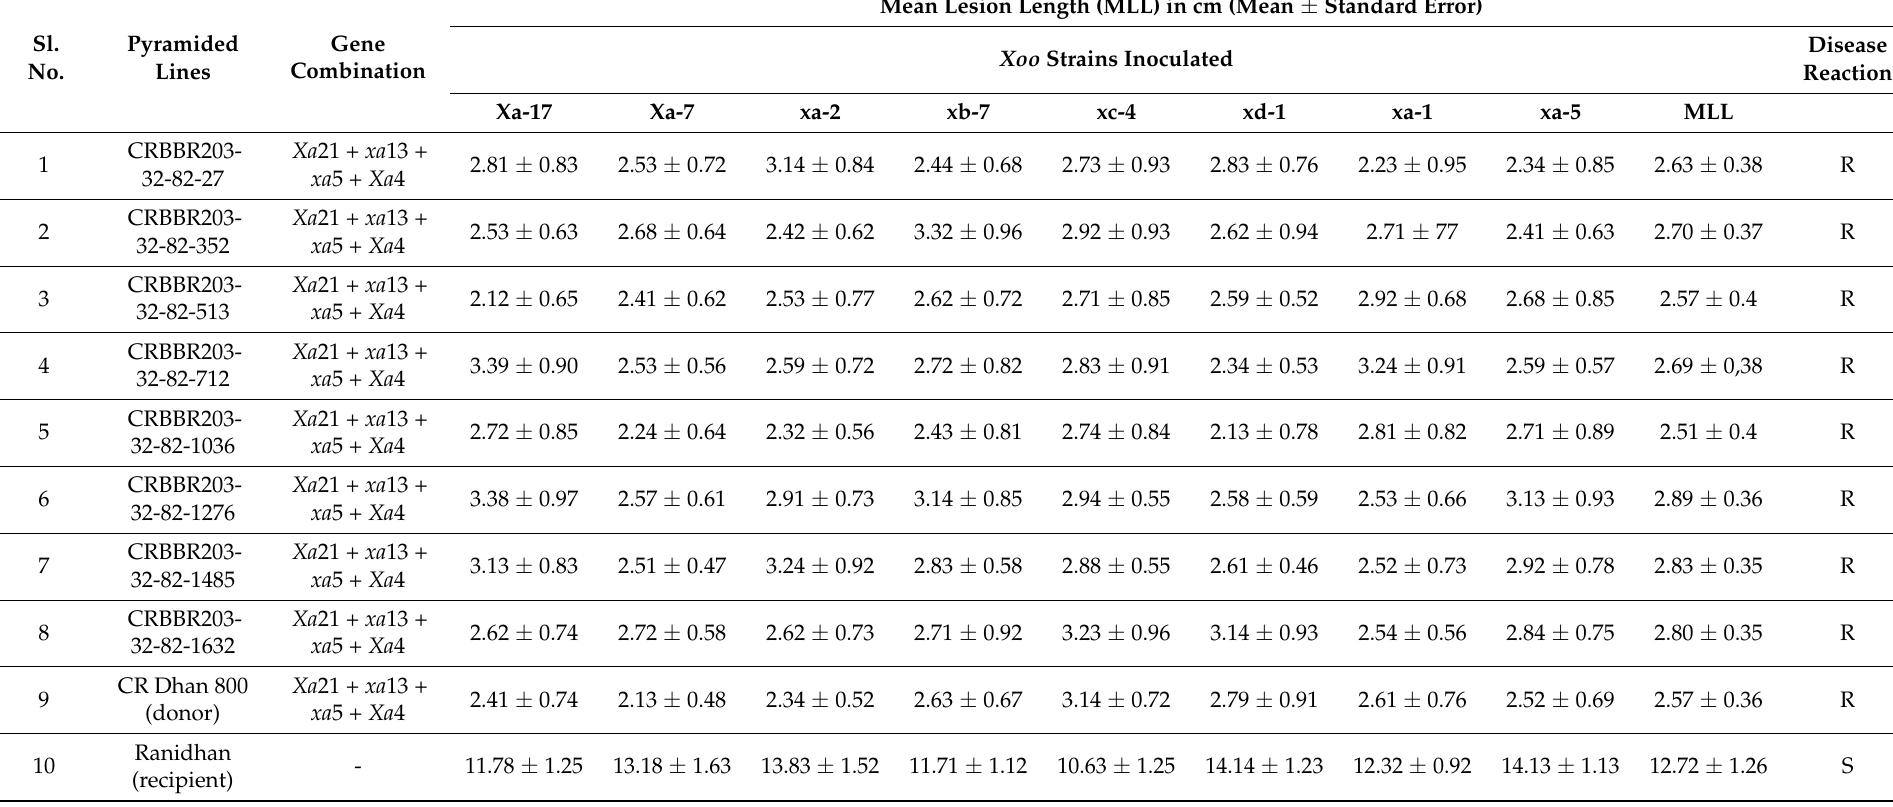
Table 2. Bioassay of BC 3 F 3 and BC 3 F 4 pyramided lines using eight Xoo -inoculated strains. R—Resistant; MR—Moderately resistant; S—Susceptible; MLL—Mean lesion length in